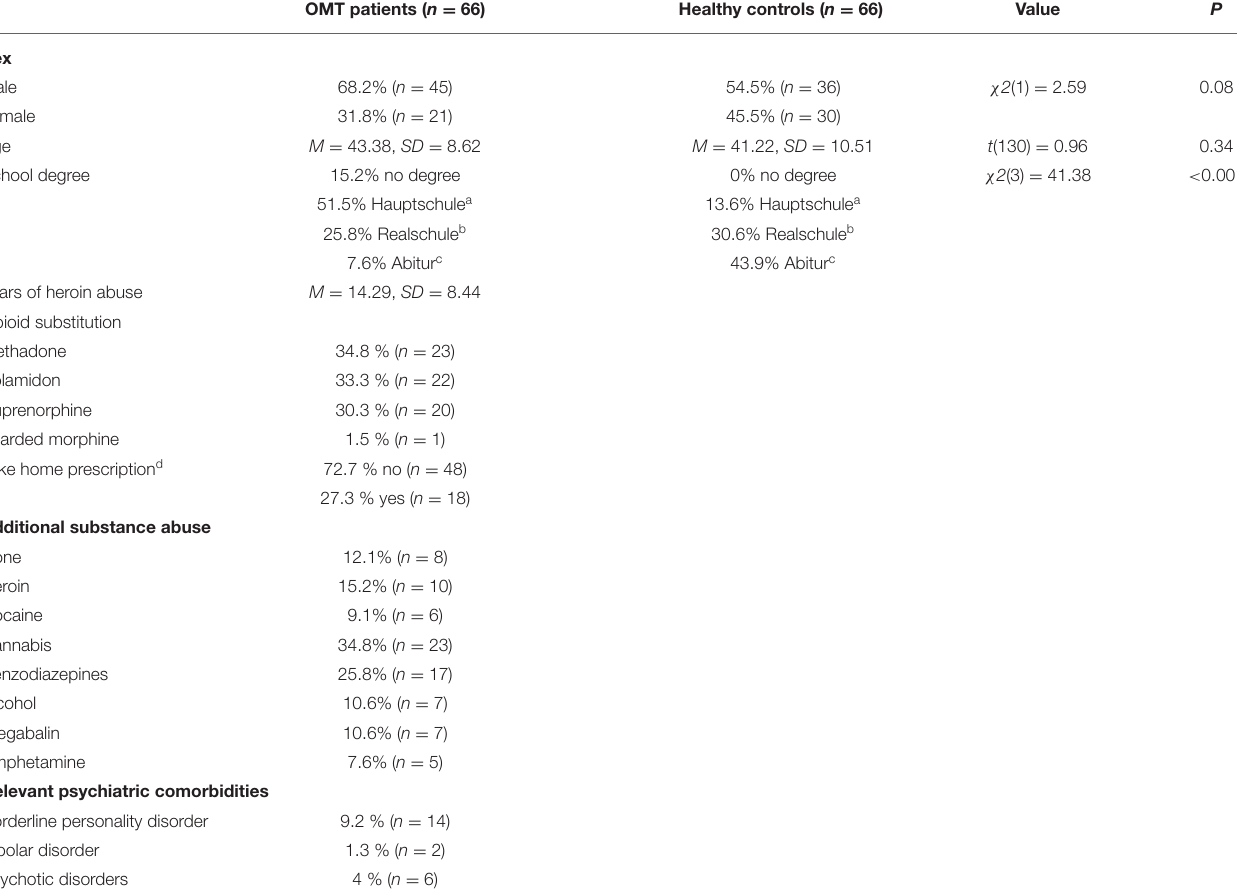
TABLE 1 | Demographic characteristics of study